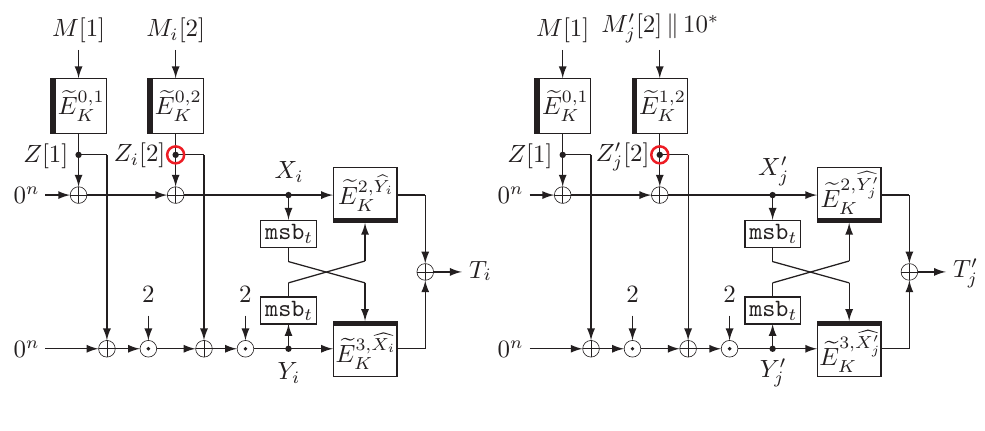
Figure 5: Our attack against PMACx. The attack makes use of a collision between Z i [2] and Z 0 [2], which are highlighted with the red circles. Both M [1]’s in the left and j